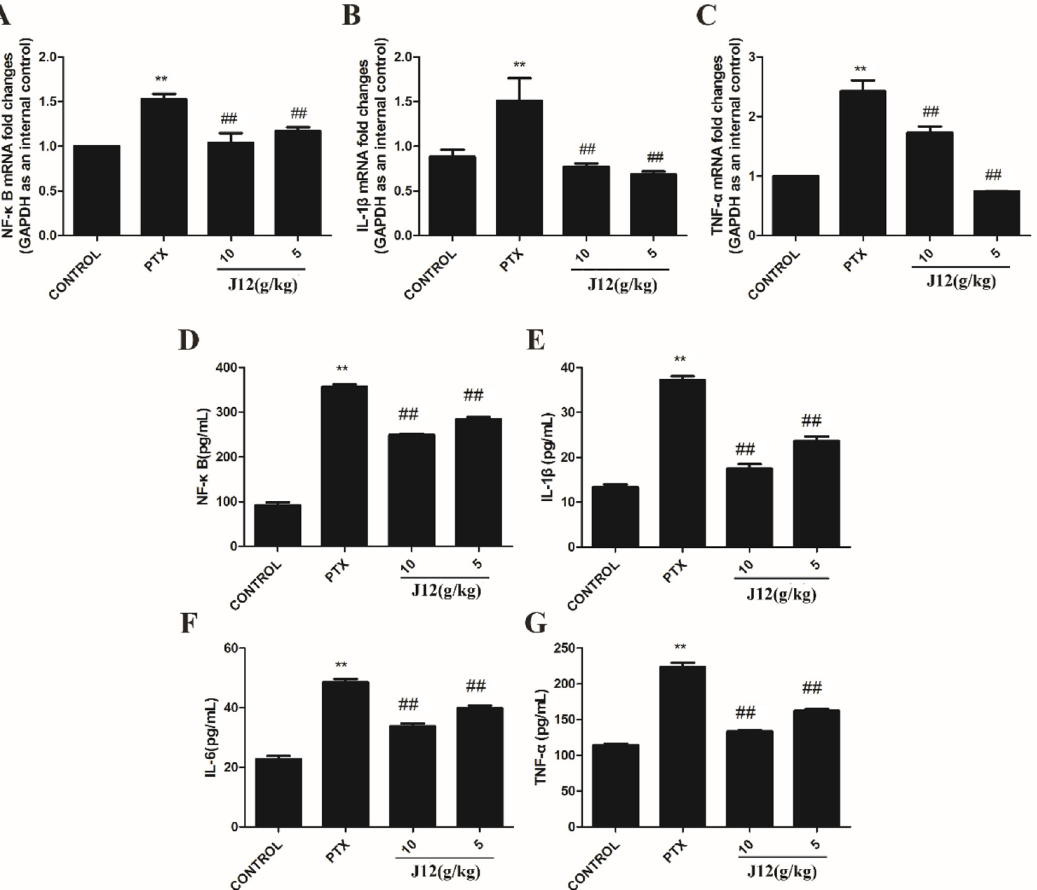
Fig. 4. Effect of J12 on paclitaxel-induced NF- k B and in fl ammatory cytokines in mice. Levels of NF- k B, IL-1 b and TNF- a mRNA transcripts were determined using real-time-PCR. (A – C) Treatment with PTX increased the mRNA expressions of NF- k B, IL-1 b and TNF- a in DRG neurons as compared with control mice. Injection of J12 attenuated the expressions. Using ELISA kits, we examined levels of NF- k B, TNF- a , IL-6 and IL-1 b . (D – G) ELISA analysis showing that J12 attenuated paclitaxel-induced increased expressions. n = 5 in each group. **vs Control, p < 0.01; ## vs PTX, p < 0.01. Data are expressed as mean ±